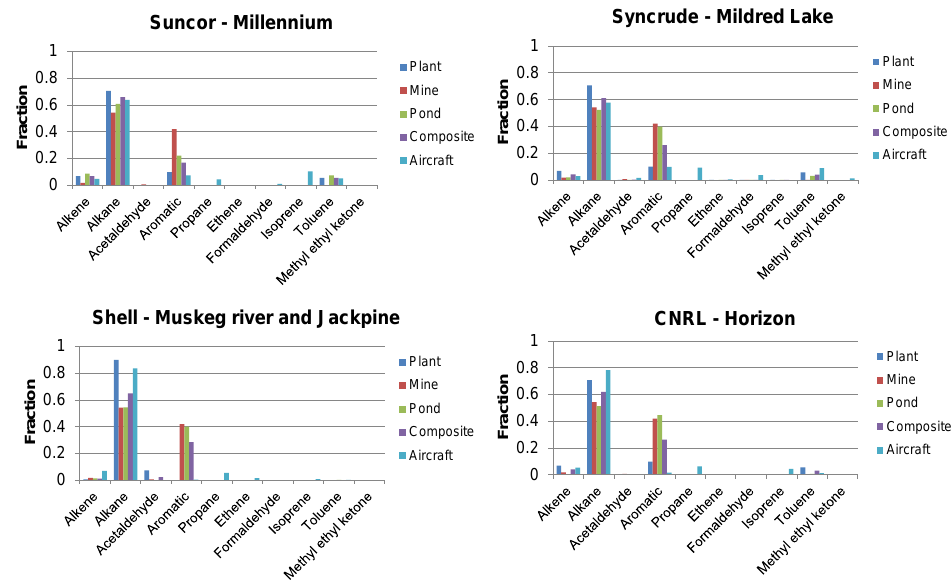
Figure 8. Comparisons of facility-specific VOC speciation profiles for ADOM-2 mechanism for four AOSR mining facilities used for the base-case study with facility-specific profiles derived from aircraft observations. Different VOC speciation profiles for plants, mine faces, and tailings ponds were used for the base-case study. The “composite” VOC speciation profile for the base case is an emissions-weighted combination of the plant, mine-face, and tailings-pond profiles for each facility to allow comparison with the aircraft-based facility-specific VOC speciation profiles.